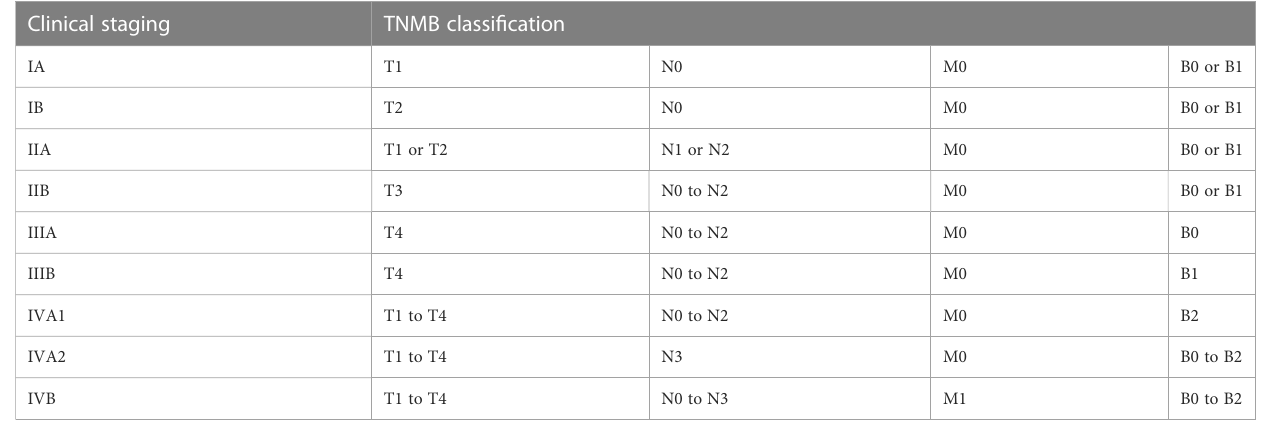
TABLE 3 Clinical staging system for MF and SS. Clinical